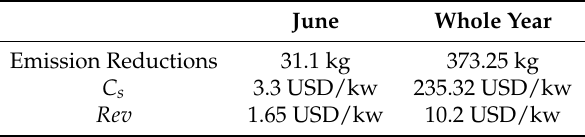
Table 3. The comparison table for